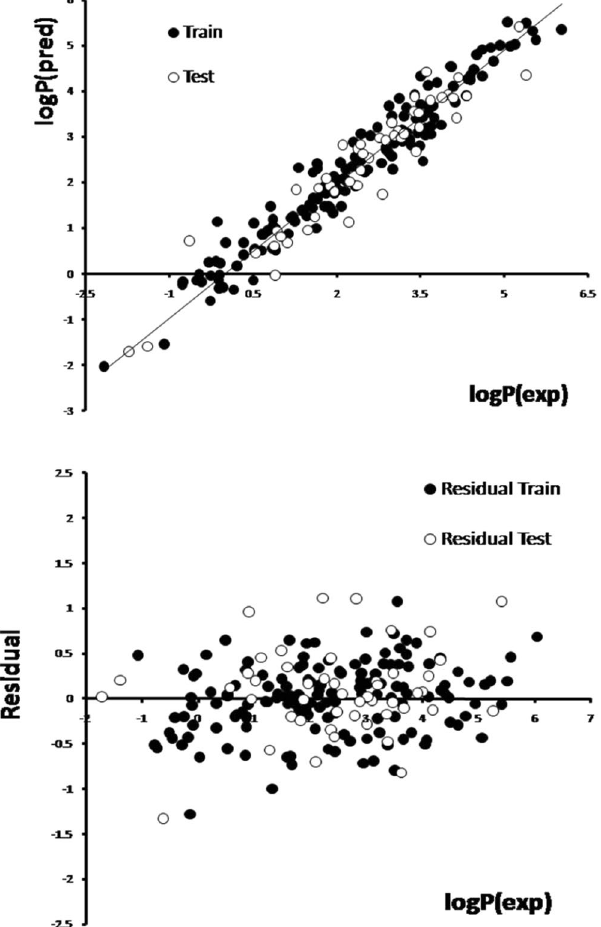
Figure 1. ( A) Plot of predicted versus experimental of logP o/w values. ( B ) Plot of residual versus experimental of logP o/w values.